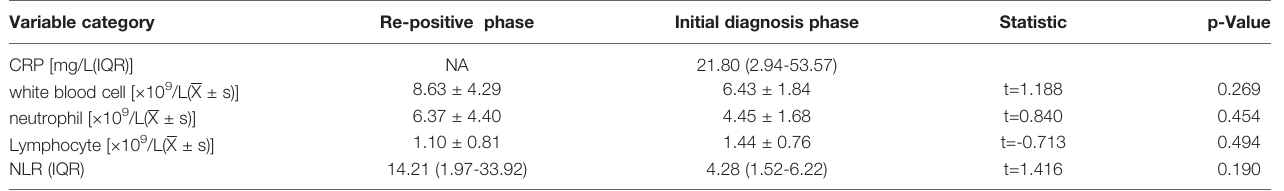
TABLE 3 | Comparison of in fl ammatory indicators between re-positive phase and initial diagnosis